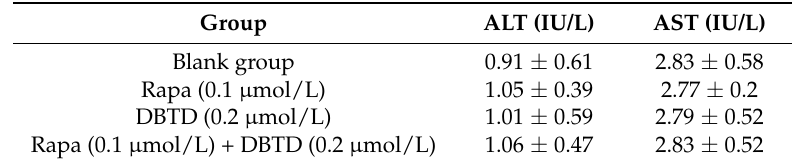
Table 4. Activities of ALT and AST in the culture media measured by kits after treatment with DBTD and